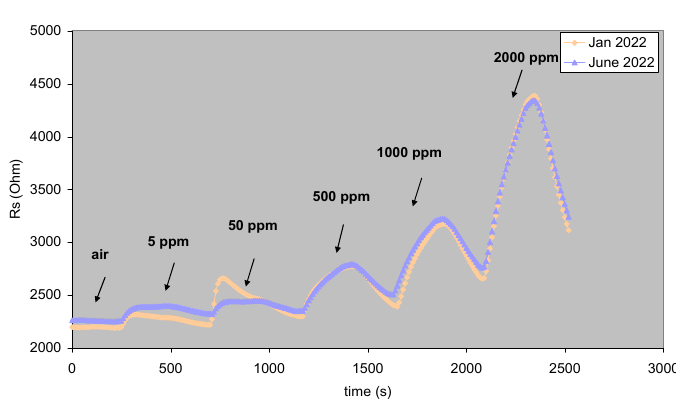
Figure 32. S3 sensor stability test (6-month period), from ref. [155]. As seen in Figure 32, the S3 sensor sample is stable for a 6-month period between identical sensing tests, the response to methane being virtually unchanged. Taking into account the results shown by the sensing experiments, we can conclude that the prepared sensor series meet the 3S parameter requirements in order to consider a sensor prototype for further development towards mass-production. The prepared sensor series is char- acterized by high sensitivity, selectivity (for the S5 sensor sample), and stability, together with other favorable characteristics such as a relatively low working temperature, a short response, and full sensor recovery, the cobalt oxide-based S5 sensor being a very prom- ising candidate for a future portable methane detector, which can be mass-produced.